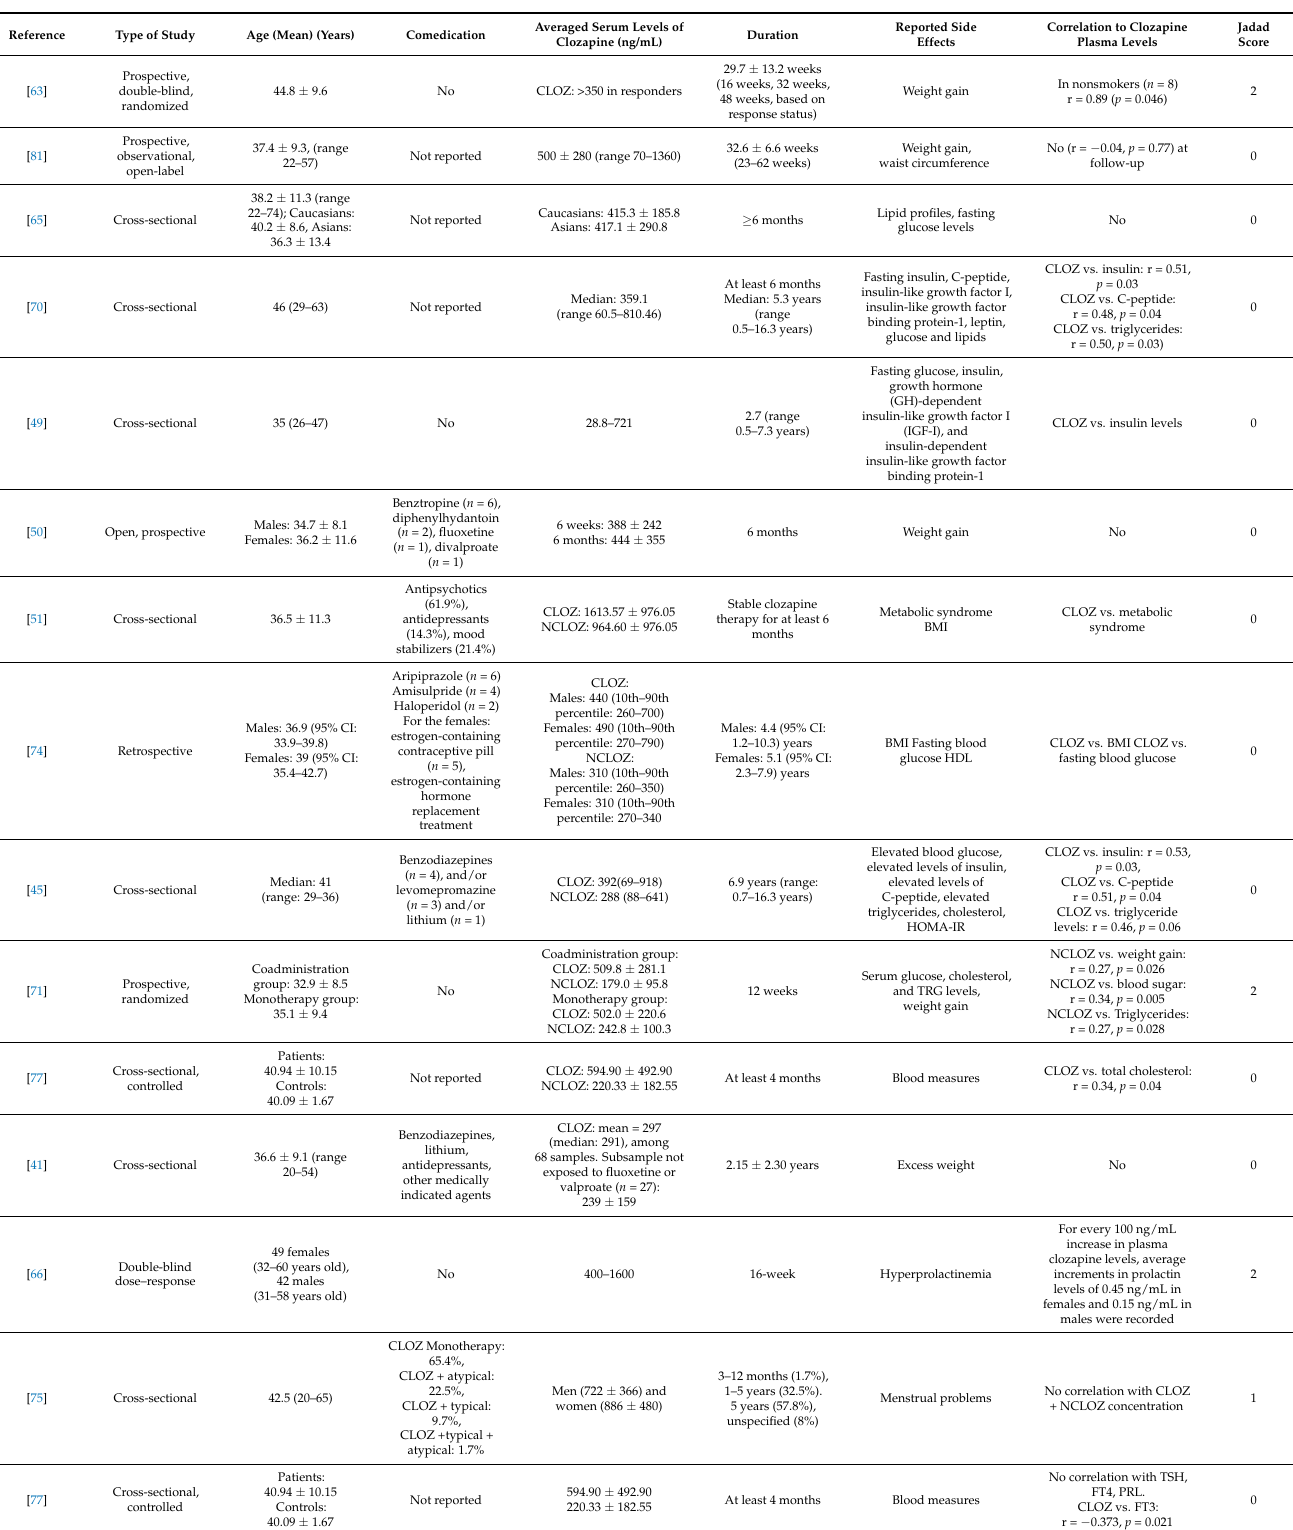
Table 5. Metabolic and endocrine adverse effects in relation to clozapine plasma